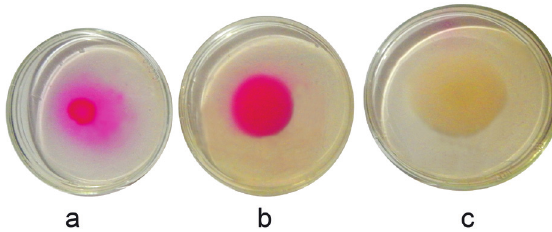
Figure 5 - Acid phosphatase detection zones. ( a ) Solubilization zone classified as ++, ( b ) solubilization zone classified as +, and ( c ) an isolate negative for acid phosphatase